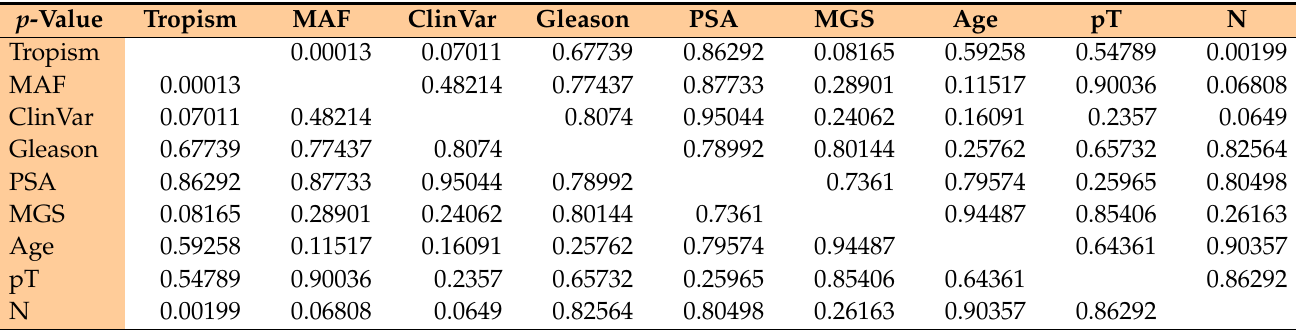
Table 3. p -values of the correlation test between all variables.